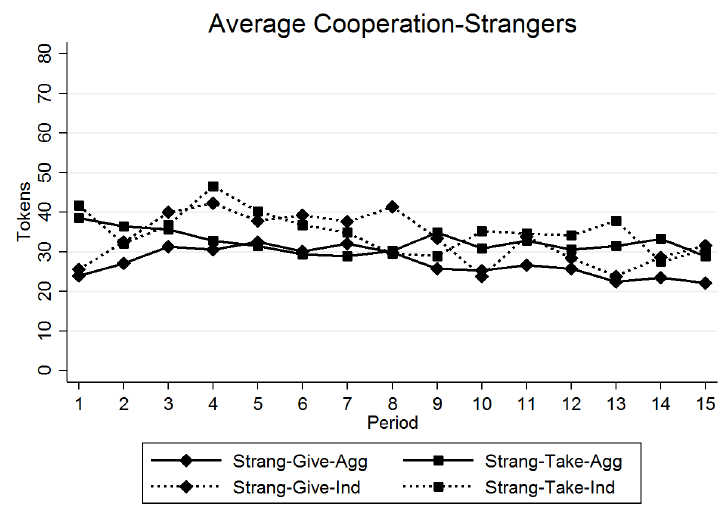
Figure 4. Average Cooperation Over Time (Strangers).